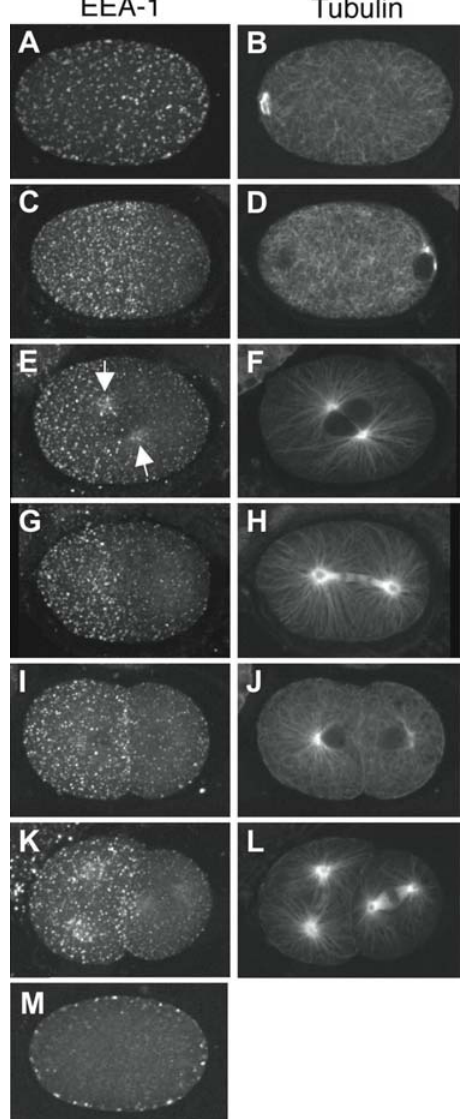
Figure 1. Early endosomes become enriched in the anterior during the first cell cycle. Shown are projections of EEs during the first two cell cycles visualised using anti-EEA-1 and a single focal plane of microtubules visualised using anti-tubulin. (A, B) meiosis. (C, D) polarity establishment; beginning of sperm aster growth. (E, F) prophase; arrows point to enrichment around the asters. (G, H) anaphase. (I, J) Early two cell stage. (K, L) Late two cell stage. (M) central focal plane of embryo in (A,B), showing that EEs are cortically associated. EEs are evenly distributed in meiosis (A), then become depleted from the posterior near the site of the sperm pronucleus (C). Anterior enrichment of EEs is maintained throughout the rest of the cell cycle and in the two cell stage. During meiotic divisions, there is a small clearing of EEs around the meiotic spindle (data not shown). Anterior, left.